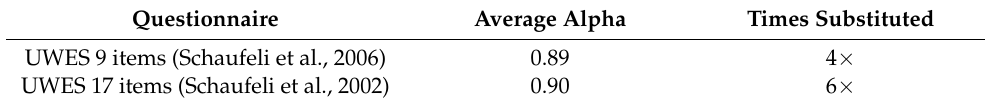
Table A2. Substitution for Cronbach’s alpha of the engagement questionnaires.